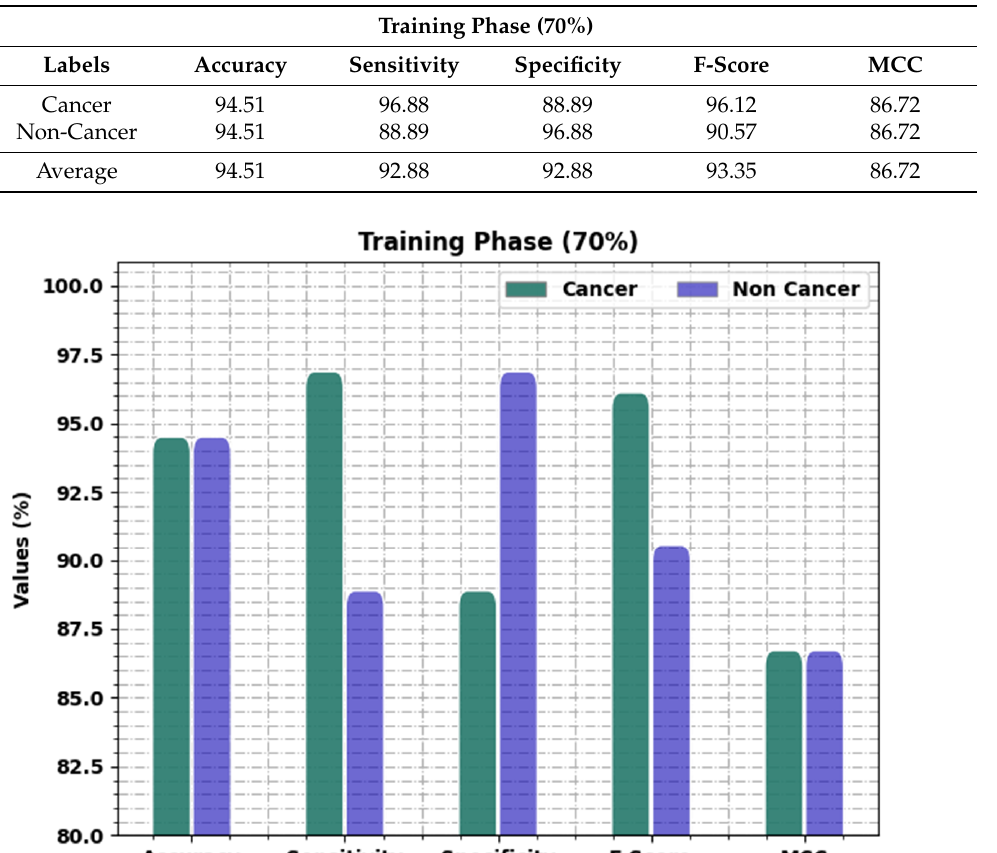
Table 4. Result analysis of OIDCNN-OPMDD approach with distinct class labels under 70% of TR data.